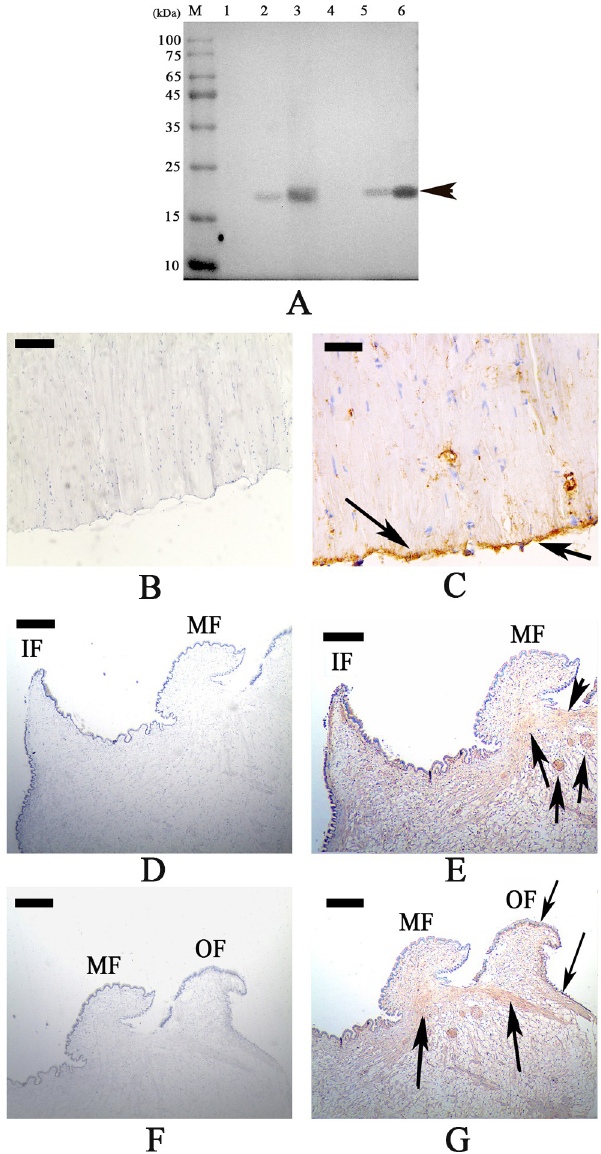
Fig 9. Western blot and immunohistochemistry analysis of WLP. A: Western blot by anti-rWLP antibody in shell matrices. Lane M, protein marker; Lane 1, soluble fraction from the fibrous prismatic layer; Lane 2, soluble fraction from the nacre layer; Lane 3, soluble fraction from the myostracum layer; Lane 4, insoluble fraction from the fibrous prismatic layer; Lane 5, insoluble fraction from the nacre layer; Lane 6, insoluble fraction from the myostracum layer. B: immunohistochemistry analysis with the control group of adductor muscle performed using only second antibody showed no significant signals; C: detection of WLP in the adductor muscle and the positive signals are indicated by arrows. D: the control group of mantle, showing the inner (IF) and the middle fold (MF) E: detection of WLP in the mantle and the positive signal is indicated by arrows; F: the control group of mantle, showing the middle (MF) and the outer fold (OF). G: detection of WLP in the mantle and the positive signals are indicated by arrows. The scale bar, 50 μ m for A, C~F, and 25 μ m for B.